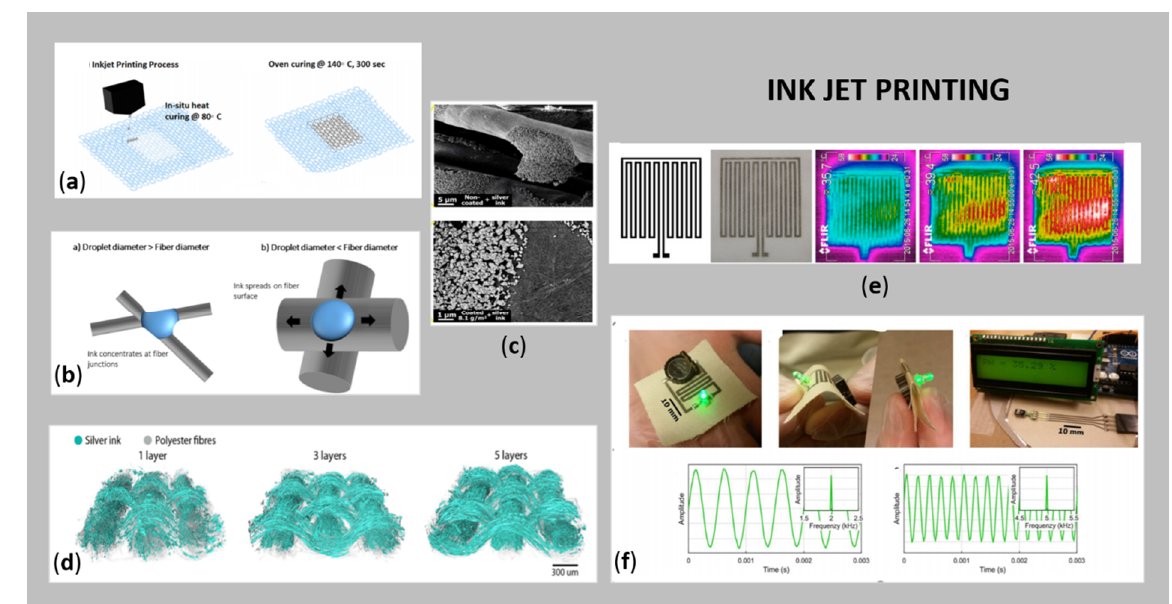
Figure 3. ( a ) Schematic presentation of inkjet printing of conductive Ag ink on textiles (reprinted with permission from Ref. [37] Copyright 2021, American Chemical Society); ( b ) presentation of a drop of Ag ink distribution on fibers with different diameters (reprinted with permission from Ref. [37] Copyright 2021, American Chemical Society); ( c ) SEM images of Ag inkjet printing, together with a combination of cellulose nanofibrils/glycerol on woven cotton fabric (reprinted with permission from Ref. [50] Copyright 2021, American Chemical Society); ( d ) XCT 3D reconstruction images of Ag (blue-green) deposited on polyester fabric (grey) with an increasing number of layers (reprinted with permission from Ref. [51] Copyright 2021 American Chemical Society); ( e ) textile heating actuators—computer designed patterns and thermal images of Ag inkjet printing PP spun non-woven textile (reprinted with permission from Ref. [52] Copyright 2021, Elsevier); and ( f ) digital moisture sensor signals recorded from the inkjet printing part on the fabric (reprinted with permission from Ref. [50] Copyright 2021, American Chemical Society).